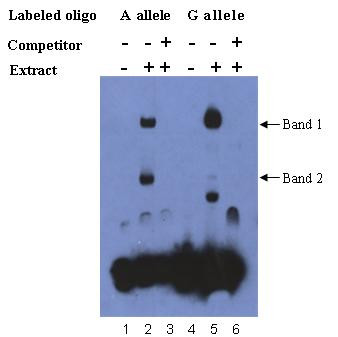
Alleles of rs2794521 differentially bind transcription factor(s). EMSA was performed by using biotin-labeled probe A or probe G with HepG2 cell nuclear extract, with or without competition from unlabeled probe A or probe G. The GR binds to a GRE as a monomer and a dimer as previously reported, and the incubation of nuclear extract of HepG2 cells with probe A showed two kinds of DNA-protein complex with the GR motif oligonucleotide probes, which probably represent monomer (Band 2) and dimer (Band 1) of GR (Lane 2). The incubation of nuclear extract of HepG2 cells with probe G showed a large increase in the dimer (Lane 5, band 1), and a dramatic reduction in monomer (Lane 5, band 2). The experiments were repeated three times with similar results.